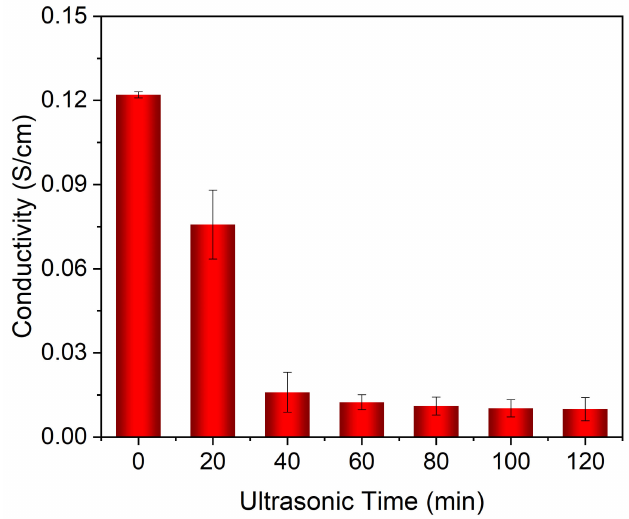
Figure 8. The conductivity of PDA@SEBS/MWCNTs yarn after different washing time.